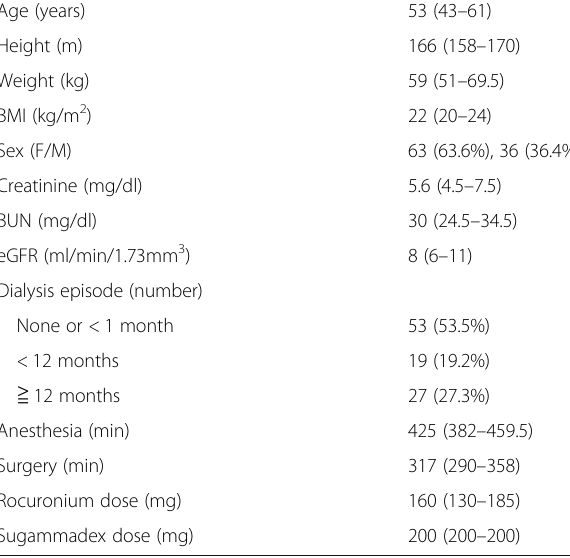
Table 1 Patient characteristics and renal function